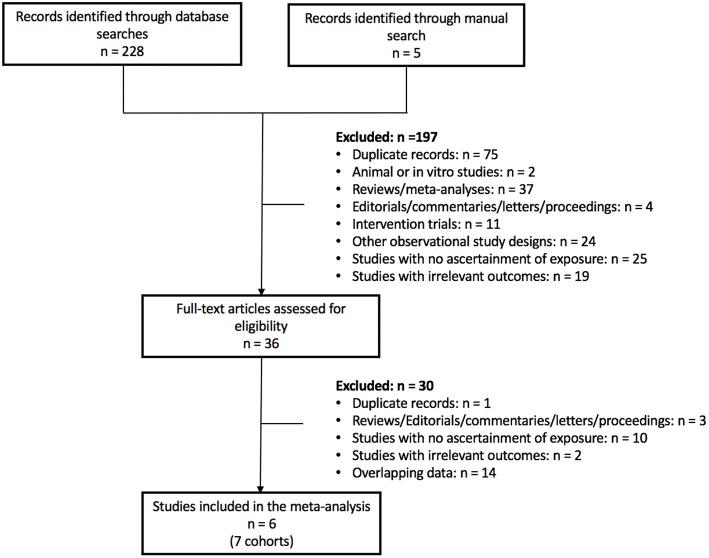
Summary of evidence search and strategy.